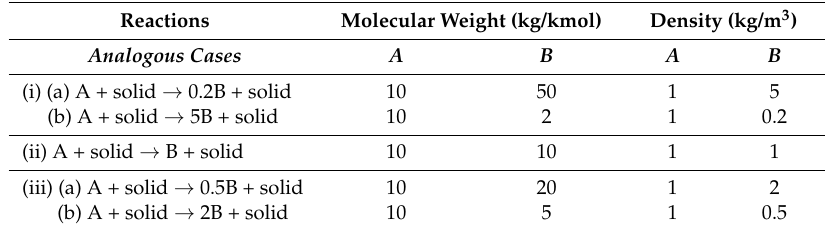
Table 3. Different catalytic reactions with their gas specie properties and length scale.